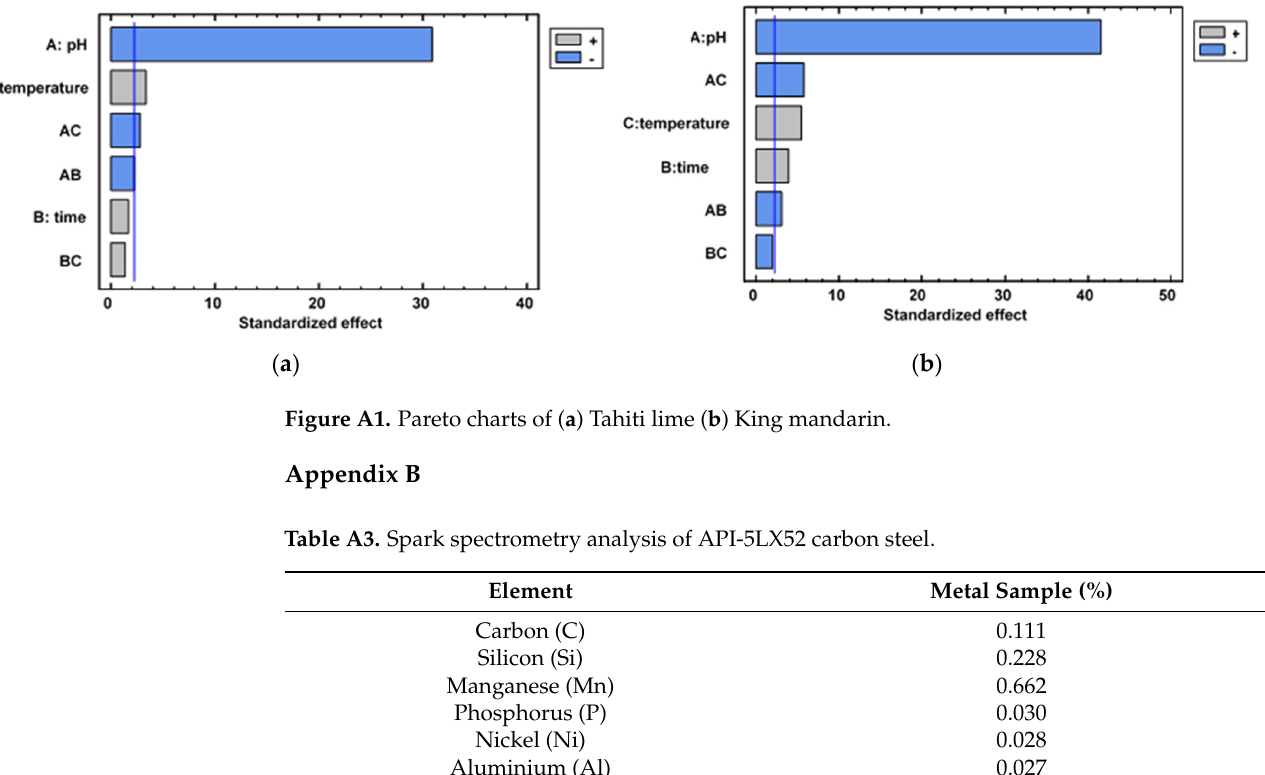
Spark spectrometry analysis was performed using a BRUKER spectrometer model Q2